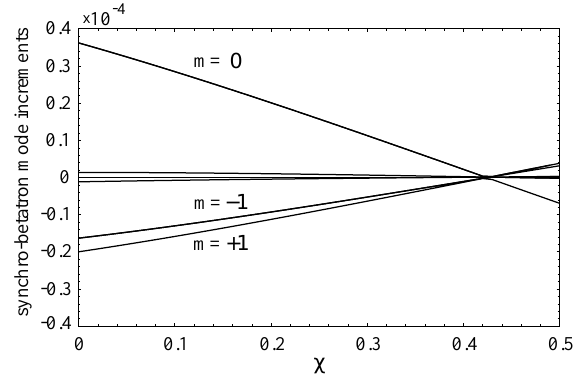
FIG. 9. Synchrobetatron mode increments per turn vs the chro- maticity x with constant j (cid:1) 0.01 ; other parameters are the same as in Fig. 8.